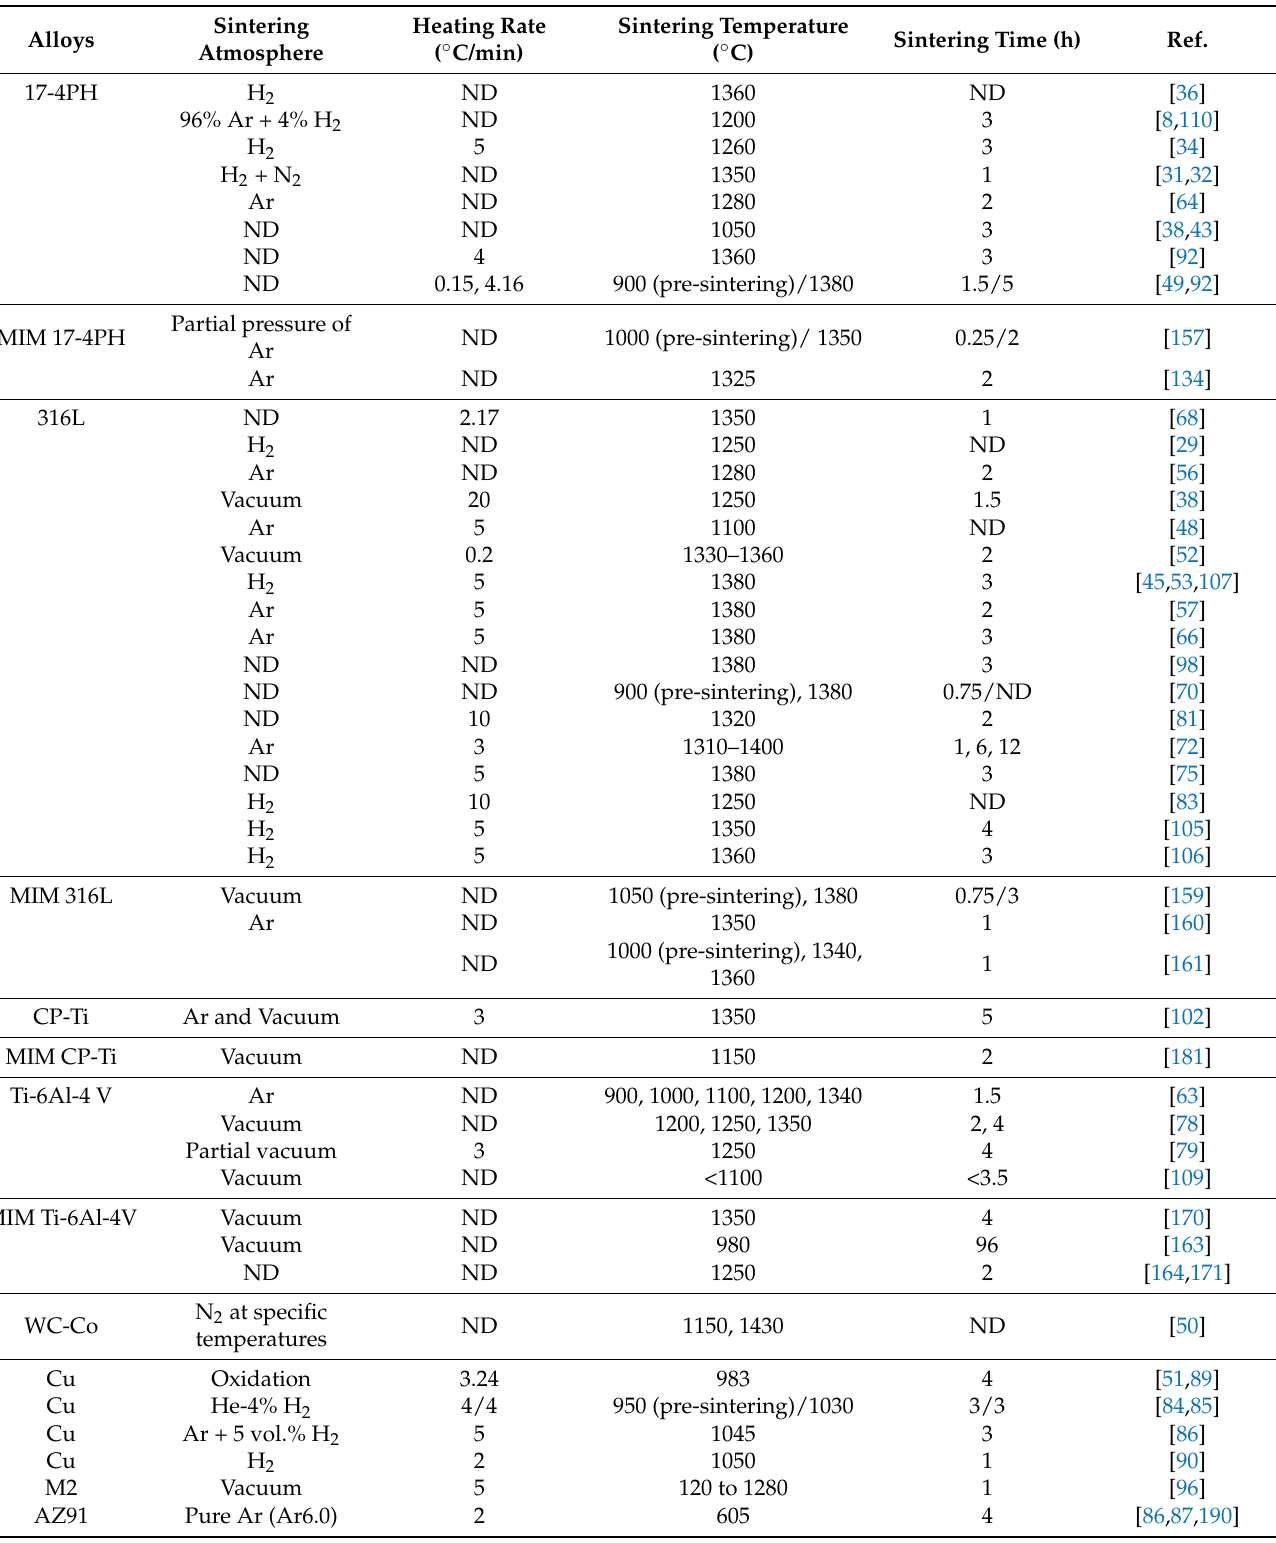
Table 5. Sintering parameters used in metal MEX and MIM processes classified by alloys (ND is no